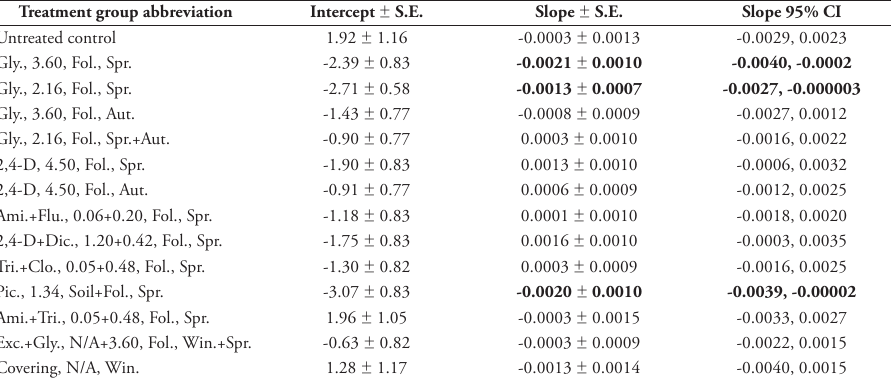
Table 2. Linear model parameter estimates for changes in Logit transformed Winter Heliotrope can- opy cover (%, m 2 ) as a function of time (days) after treatment started (Fig. 4). Full model statistics: F = 5.5, p < 0.001, R 2 = 0.53. Slope estimates in bold differ significantly from 0 at the a = 0.05 27,134 level. Treatment group abbreviations are provided in the format: treatment, application rate, application method, season of application. Abbreviations used in the treatment groups are as follows: 2,4-D = 2,4-D amine; Ami. = aminopyralid; Clo. = clopyralid; Flu. = fluroxypyr; Gly. = glyphosate; Pic. = picloram; Tri. = triclopyr; Fol. = foliar application; Exc. = excavation; Spr. = spring; Aut. =